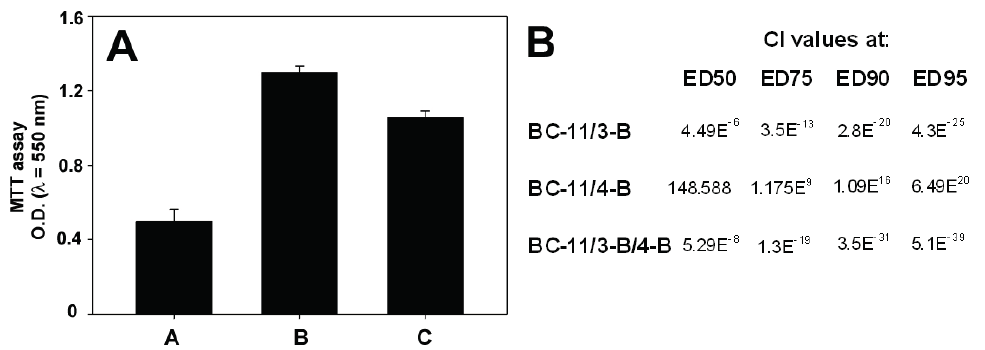
Figure 3. Effect of ATF, 3-B and 4-B on BC-11 cytotoxic activity. ( A ) MTT assay of MDA-MB231 cells treated with 117 μ M BC-11 (A), untreated (B) and treated with 117 μ M BC-11 pre-adsorbed with 100 ng ATF for 72 h. Error bars correspond to s.e.m. of three independent measurements; ( B ) CI values of BC-11 in two-drug and three-drug associations with the EGFR inhibitors 3-B and 4-B at different effect dose